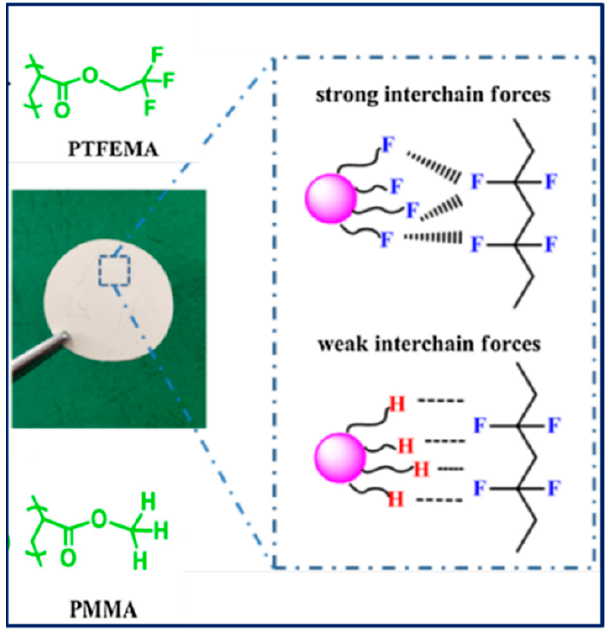
Figure 7. Fluorine-fluorine and hydrogen-fluorine interactions in the nanocomposites of PVDF and BaTiO 3 grafted with PTFEMA and PMMA, respectively. Reproduced with permission from Ref [121].